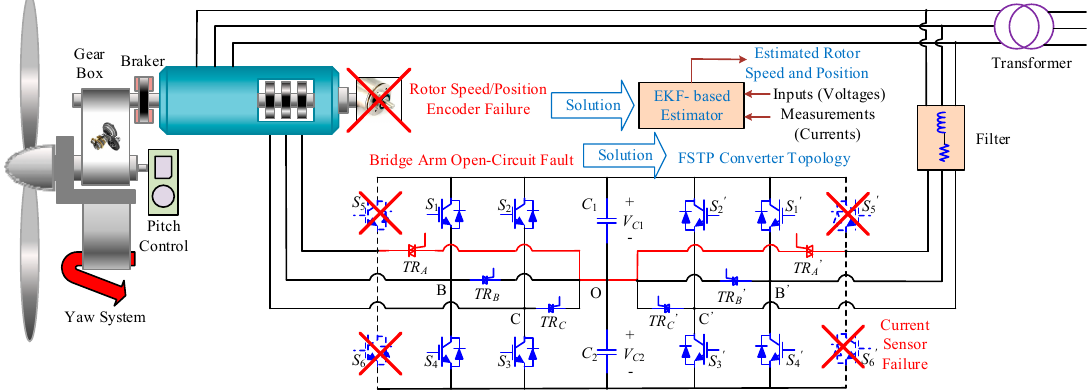
Figure 1. Rotor position encoder failure and bridge arm open-circuit fault in doubly-fed induction generator-based wind turbine (DFIG-WT). FSTP, four-switch three-phase.